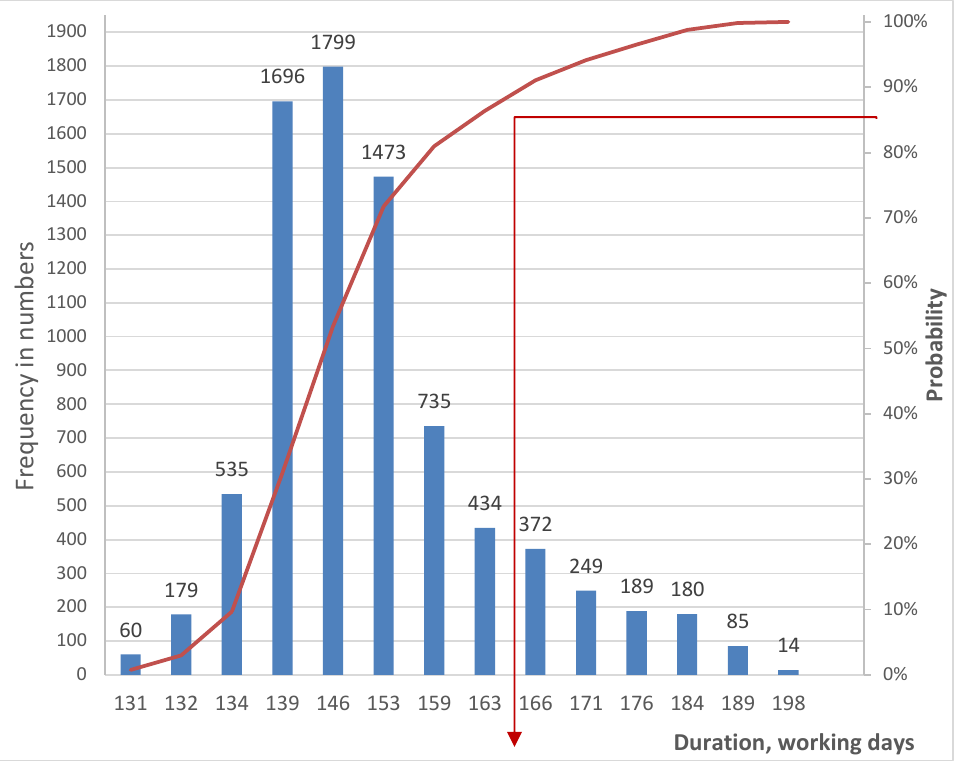
Fig. 7. Results of manual Monte Carlo simulation